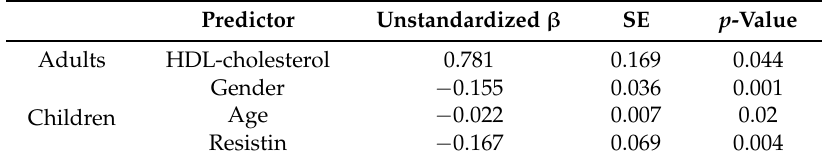
Table 3. Stepwise linear regression analysis using vitamin B12 as a dependent